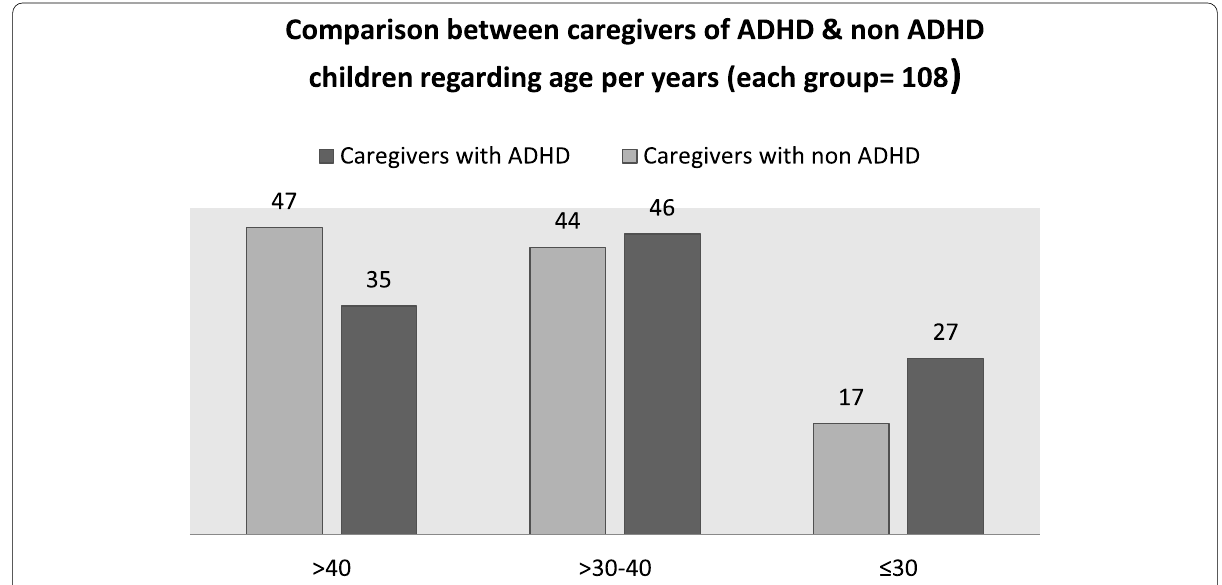
Fig. 1 Comparison between caregivers of ADHD children and non‑ADHD children regarding age per years (each group